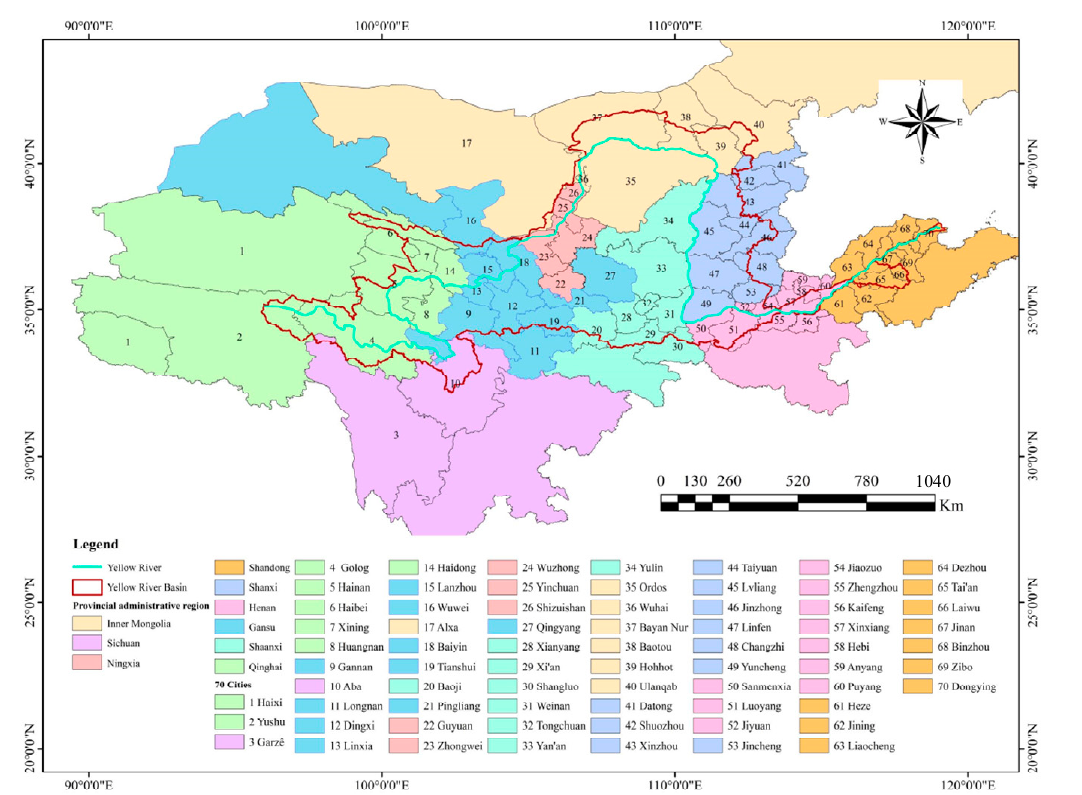
Figure 5. An overview map of 70 prefecture-level administrative regions in the Yellow River basin.